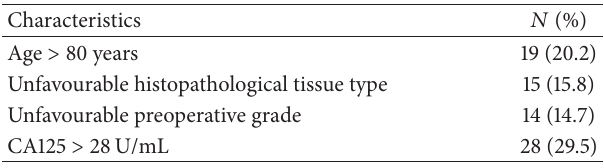
Table1:Characteristicsofpatientswithendometrialcancer 𝑁 = 95 .